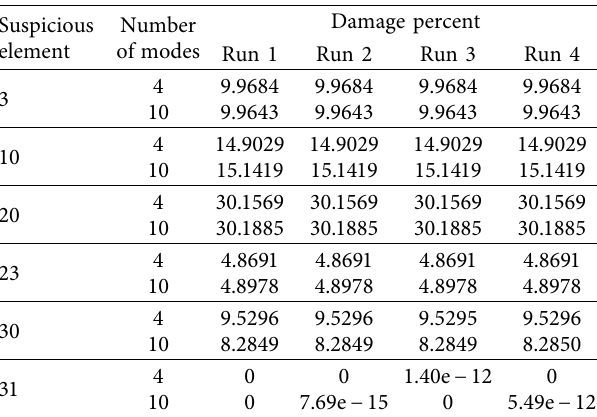
Table 3: Damage detection results of step 2 for the 35-element planar truss, 2%